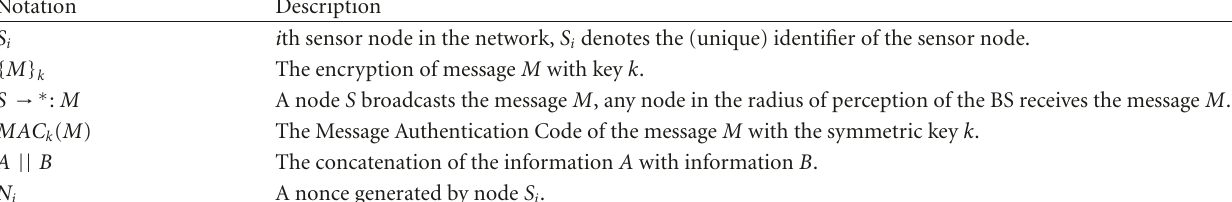
Table 1: Notation.